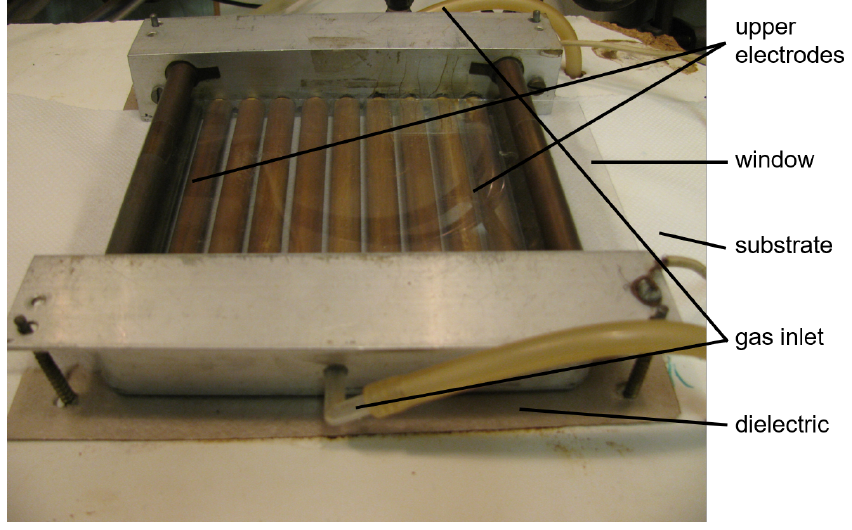
Figure 5. The image of deposition